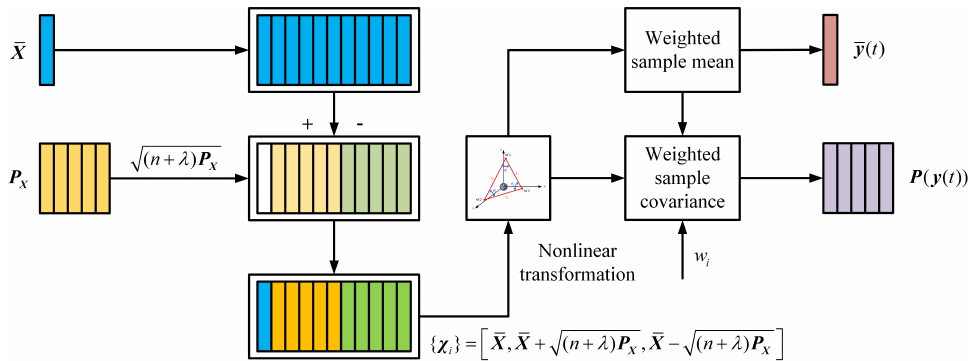
Figure 5. A schematic diagram of the unscented transformation. x and y denote the input and output variables,